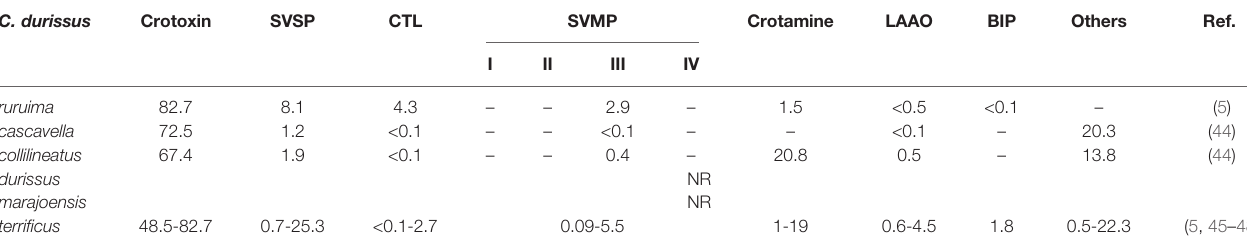
TABLE 1 | Venomic comparison of Brazilian Crotalus durissus